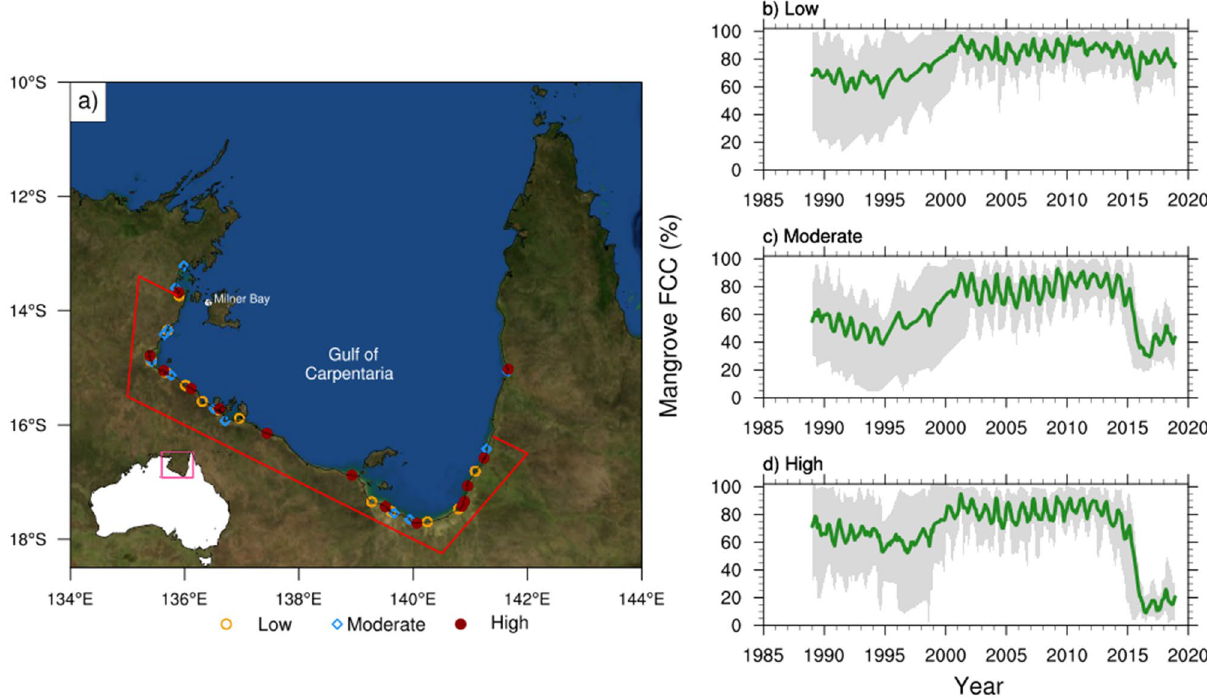
Figure 1. ( a ) Location of the mangrove FCC sampling sites along the Gulf of Carpentaria coastline with an inset in the bottom left showing the location of the Gulf of Carpentaria within Australia. The sites with three dieback classes—low (30–59%), moderate (60–79%), and high (80–100%) are marked with yellow circles, blue diamonds and maroon dots, respectively. The coastal Gulf region that is used to define T max , rainfall and ESI anomalies are shown in red polygon. The basemap image is obtained from NASA Earth Observatory (https:// visib leear th. nasa. gov/ images/ 73909/ decem ber- blue- marble- next- gener ation-w- topog raphy- and- bathy metry) and processed using the NCAR Command Language version 6.6.2 (http:// www. ncl. ucar. edu/). ( b–d ) Time evolution of mangrove FCC (in %) for the three dieback categories. The solid green curves indicate the averaged FCC across all the sites in each category, while the range of the monthly FCC is shown with grey